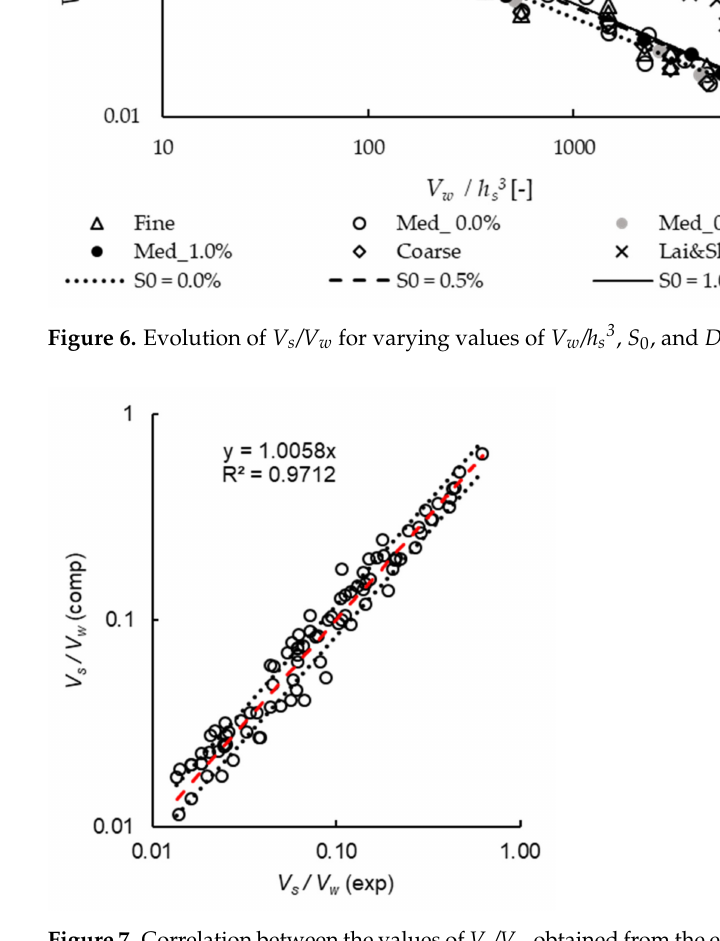
Figure 7. Correlation between the values of V s /V w obtained from the experiments and those computed with Equation (13). Dotted lines correspond to a relative error of ±